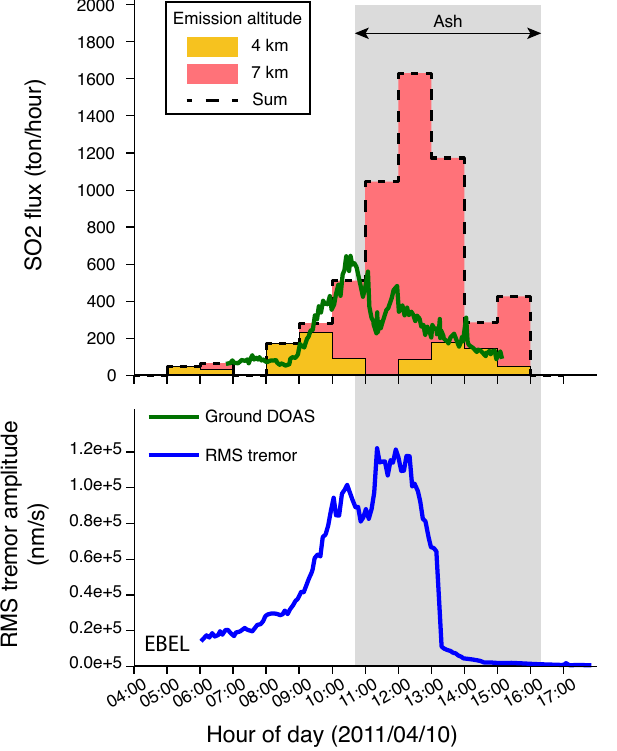
Figure 4. Maps of the cloud cover factor (CCF). The Etna IASI SO 2 cloud is shown in grey in the